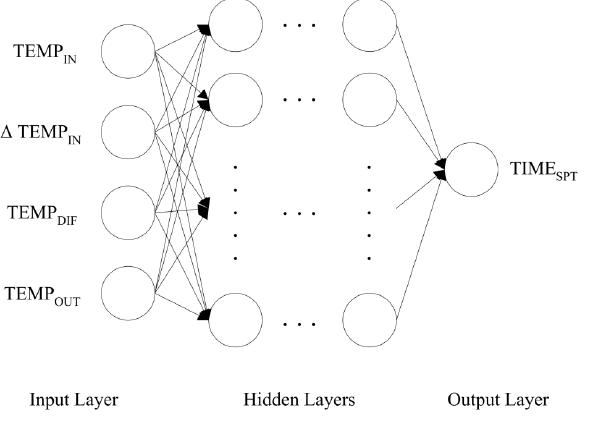
Figure 5. Structure of the initial ANN